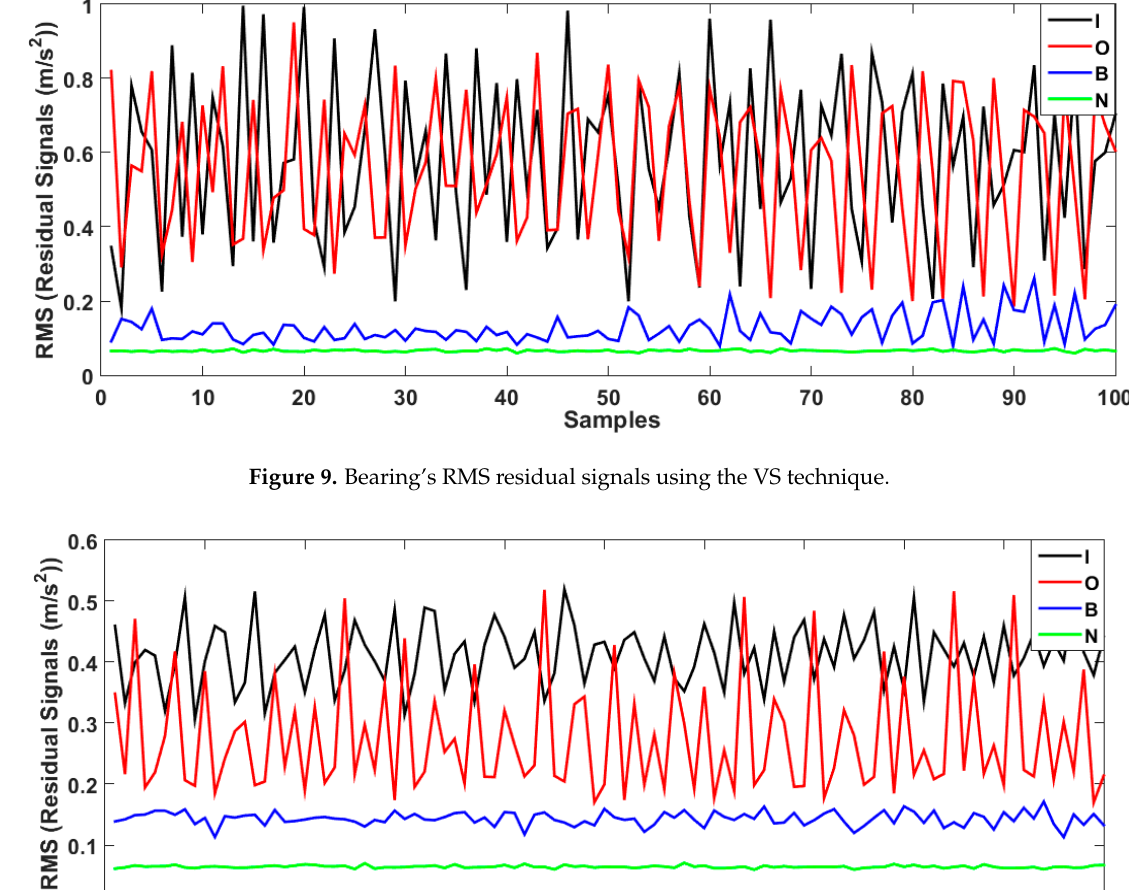
Figure 8. Bearing’s residual signals using the FVSF approach.